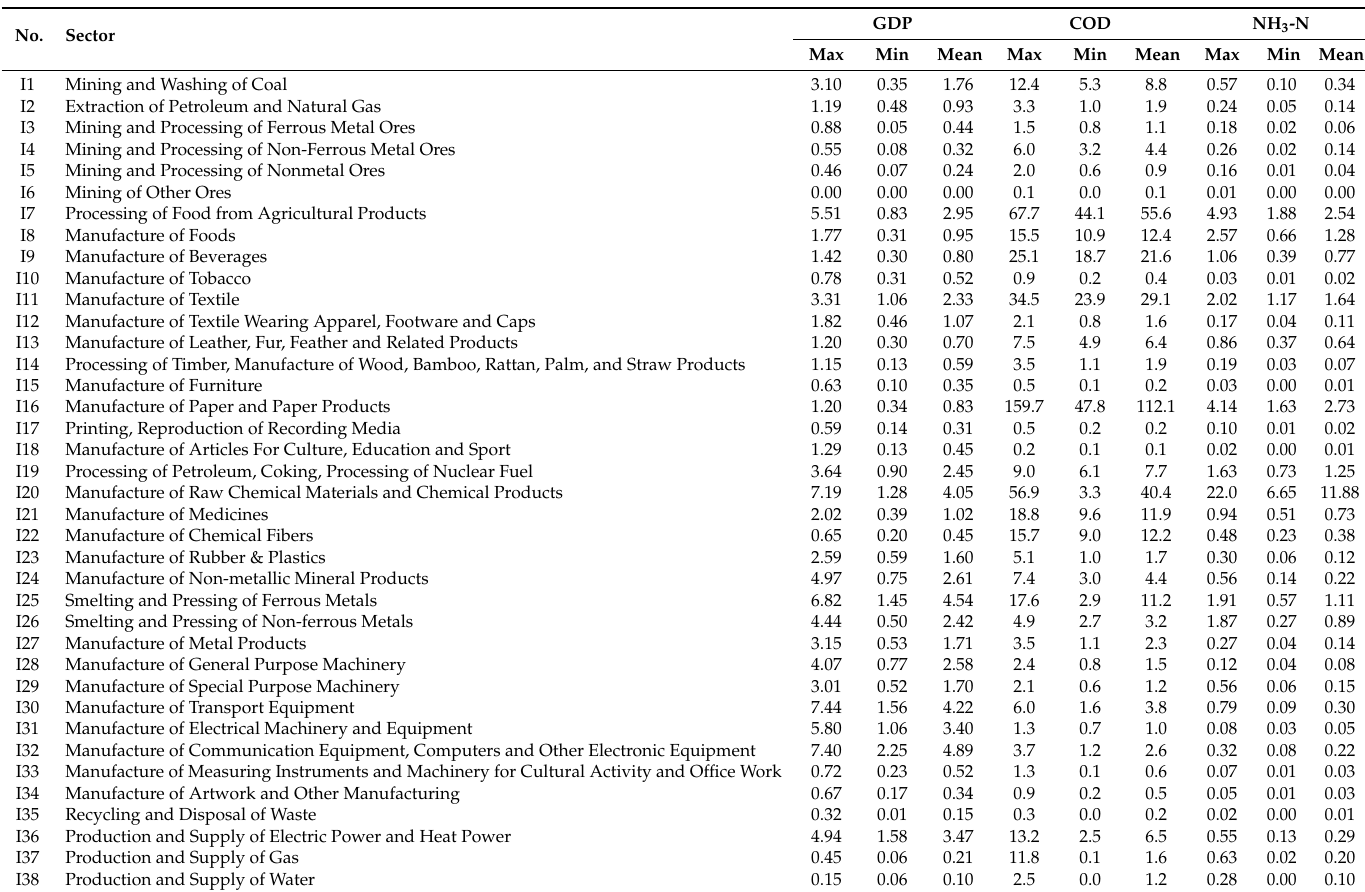
Table A1. Classification of industrial sub-sectors studied in this paper and their respective GDP (10 12 CNY), COD (10 4 t) and NH 3 -N (10 4 t) during the period 2003–2014. No.